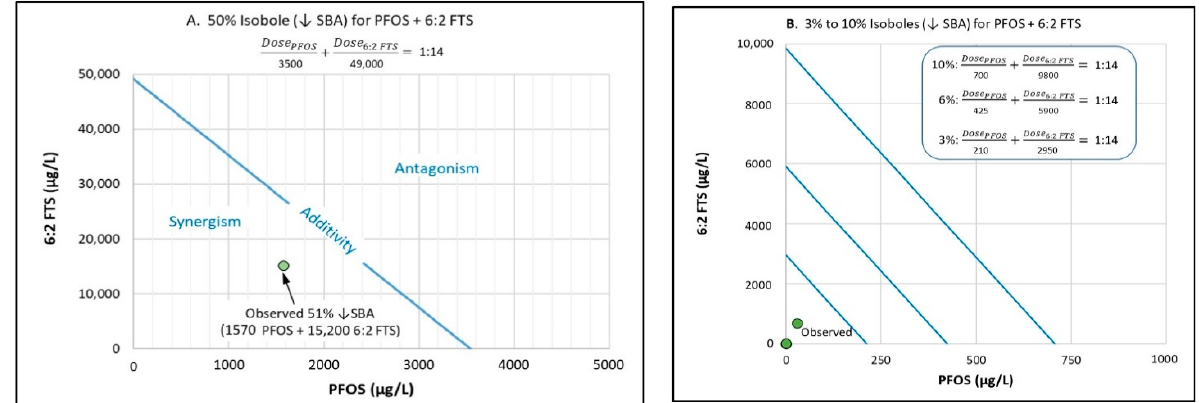
Figure 8. Isoboles for binary mixtures of PFOS and 6:2 FTS: Each line shows the predicted con- centrations of PFOS + 6:2 FTS that, together, yield a specified response level, based on the linear dose–response models fitted to the component study results: ( A ) 50% reduction in swim bladder area ( ↓ SBA); ( B ) approximately 3%, 6%, and 10% ↓ SBA. The slope of the isobole line conveys the average relative potency (RP) across the specified dose ranges; for this study, the average RP of PFOS was approximately 14 times greater than 6:2 FTS. The assumption of dose additivity is supported if ob- servations from the whole mixture study plot near the line; deviations convey potential interac- tions—synergism for points below the line (which is indicated for this study), and antagonism for points above the line [3]. Observed points are from the dose regimens for the binary mixtures ex- periment summarized in Table 1.